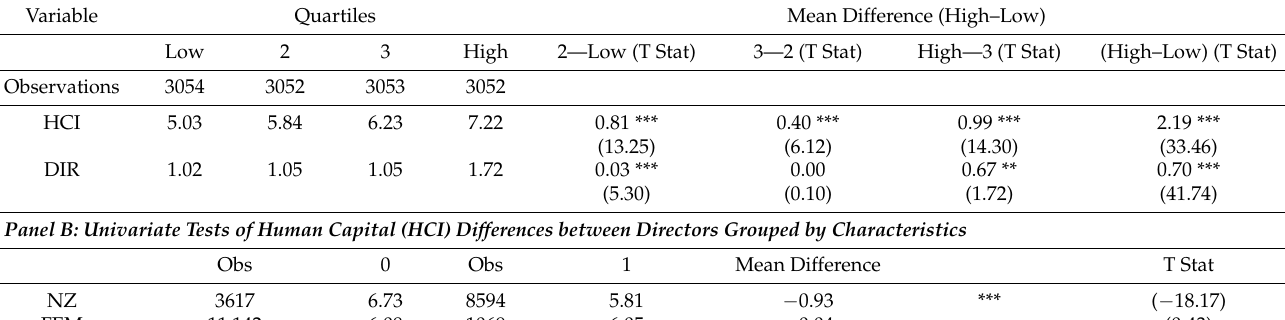
Table 4. Univariate